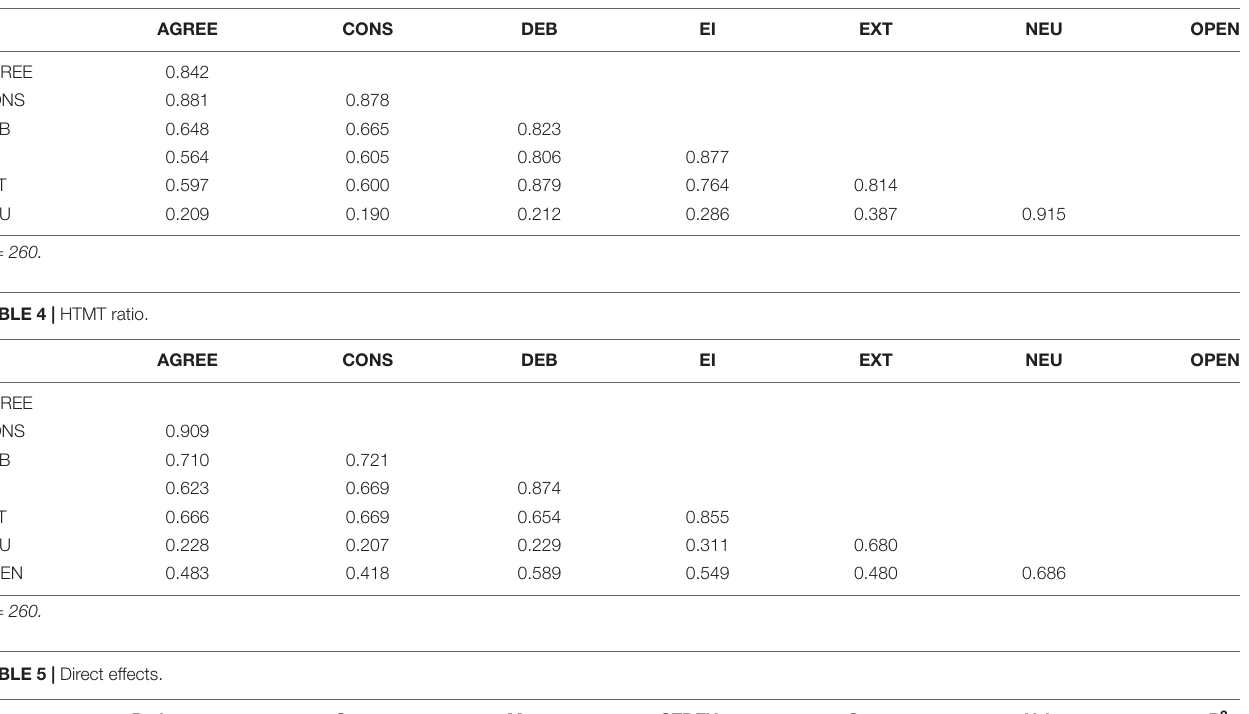
TABLE 3 | Fornell and Larcker criterion.